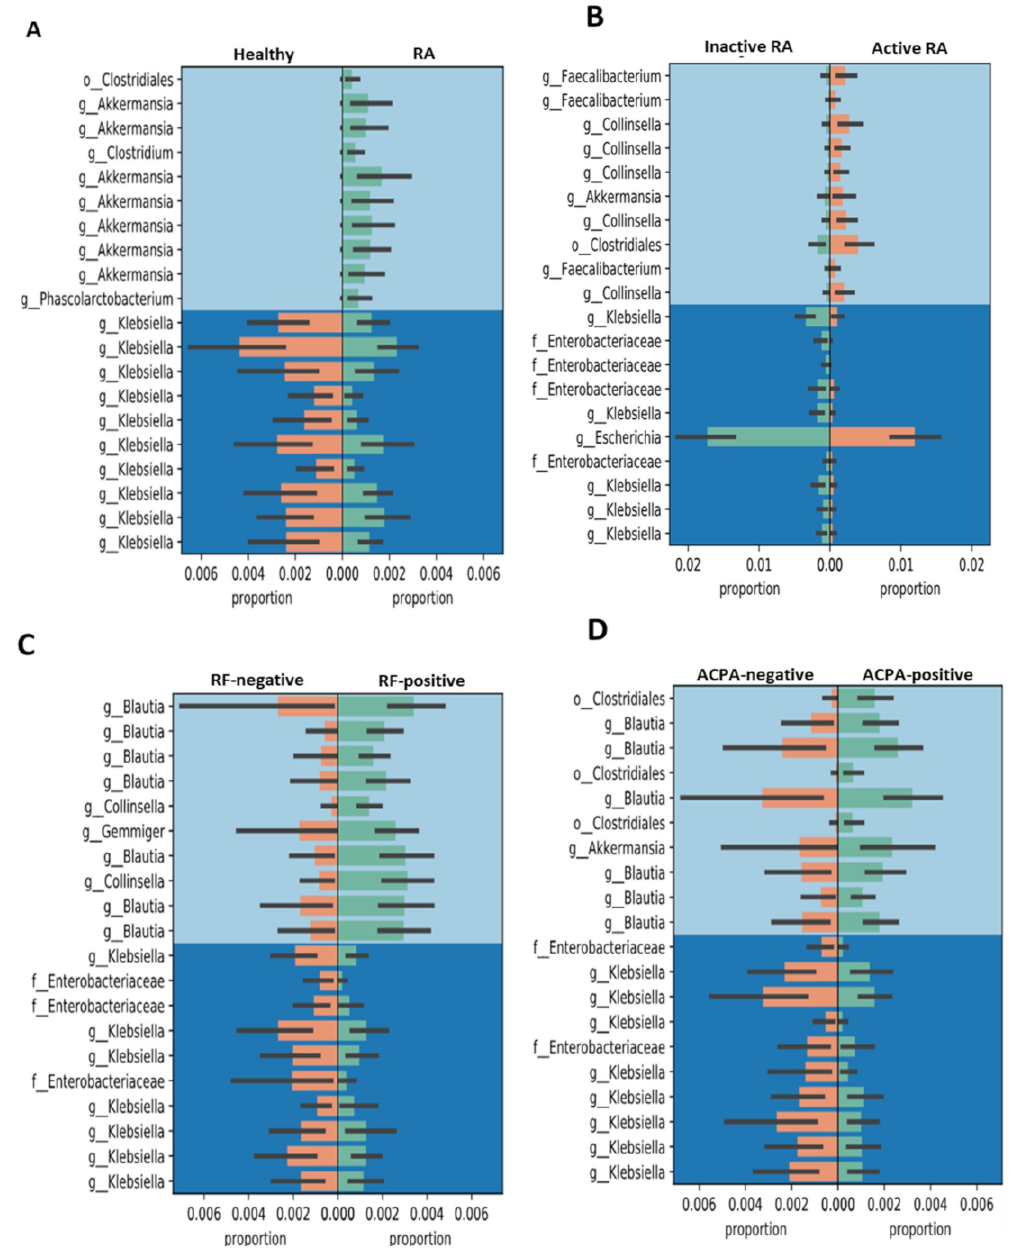
Figure 4. Di ff erences in the abundances of various bacterial Gneiss in gut microbiota among rheumatoid arthritis (RA) patients with di ff erent phenotypes and healthy controls (HC). Active RA was defined as having the 28-joint disease activity score more than 3.2. RF: rheumatoid factor; ACPA: anti-citrullinated peptides